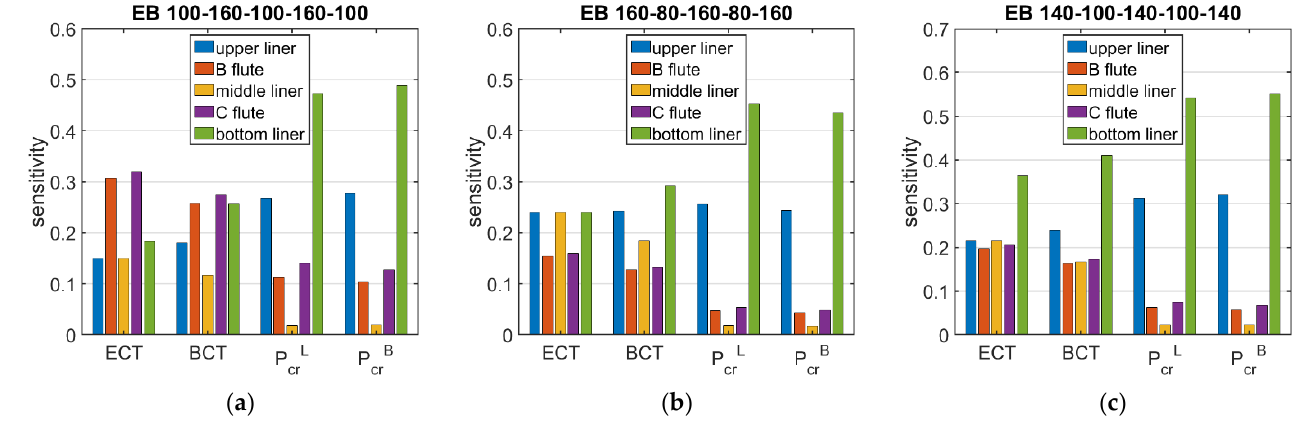
Figure 7. Average sensitivity of ECT, P cr , and BCT of all boxes in relation to the layer grammage perturbation for EB cardboard of selected grades: ( a ) 100-160-100-160-100, ( b ) 160-80-160-80-160, and ( c ) 140-100-140-100-140.